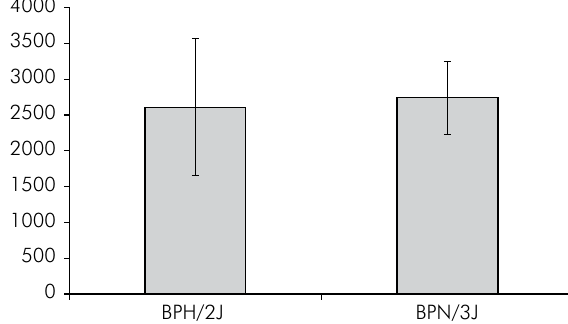
Figure 2. The average periapical lesion size in pixels in the hypertensive (BPH/2J) and normotensive (BPN/3J) conditions. The value is in mm 3 . n = 5 for each group. No statistically significant difference was